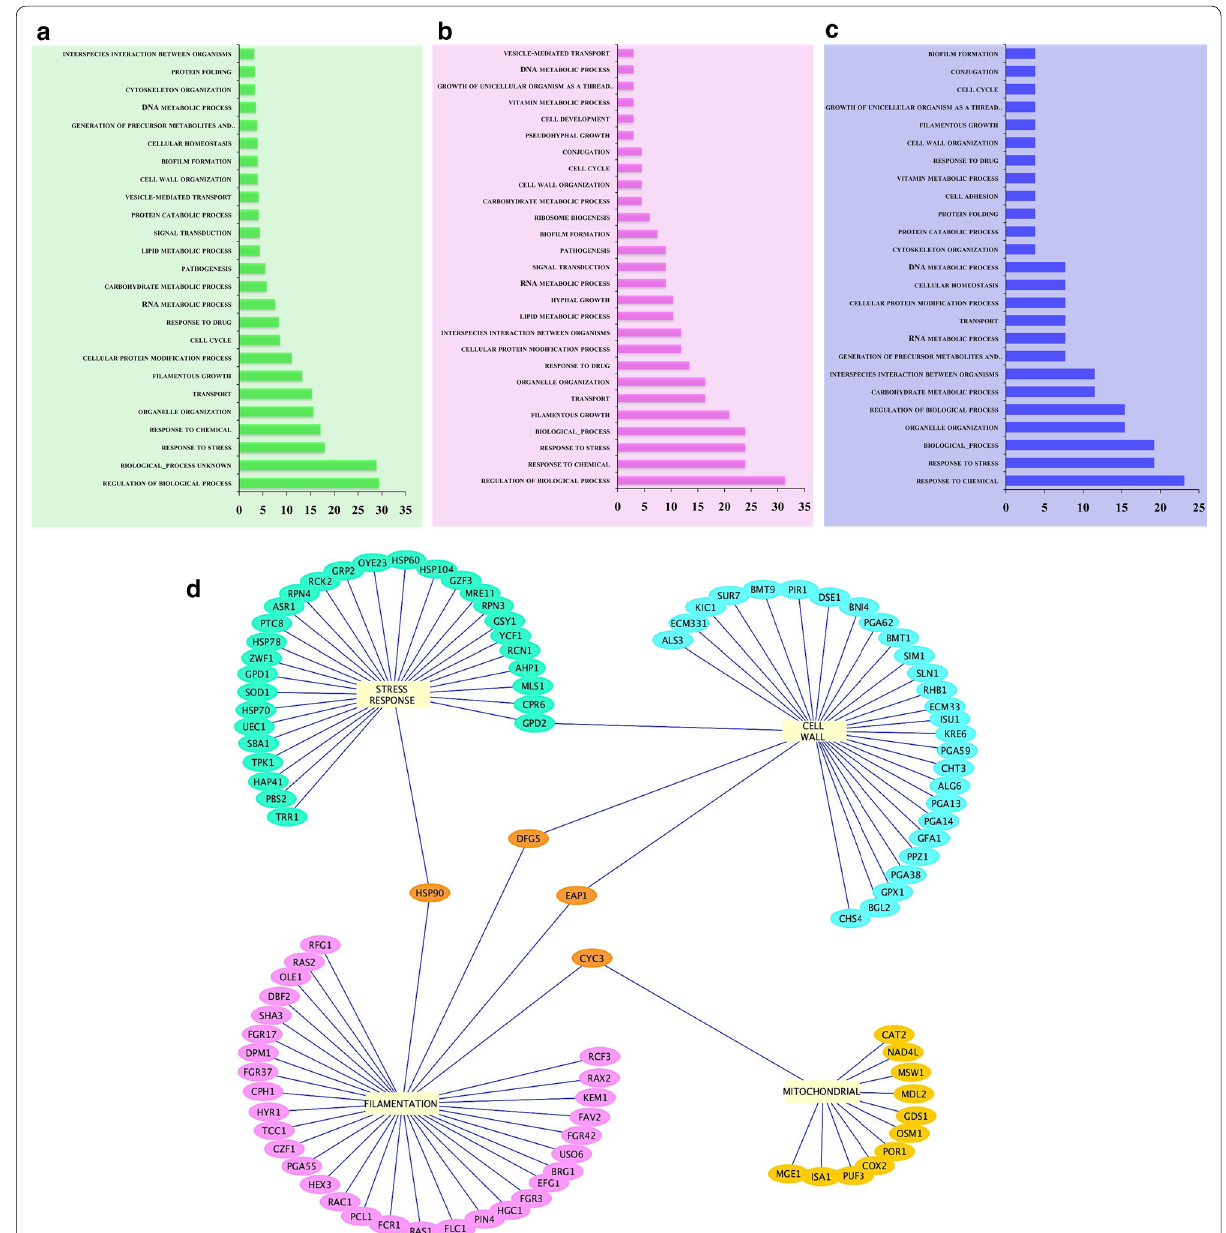
Fig. 3 General functional categories of genes enriched by Hsf1—gene ontology (GO) terms of various functions of the genes whose promoters are bound by Hsf1 ( a ) enriched both ( b ) [BPS ( )] specific ( c ) [BPS ( )] specific. Detailed list is provided in Additional file 1: Table S3. The percentage of − − genes of each category is depicted in Y-axis. X axis represents the functional category. d Major functional categories bound by Hsf1—genes of cell wall, mitochondria, filamentation and stress, which show significant promoter occupancy of Hsf1. This network was represented using Cytoscape v3.4.0 software (Seattle,